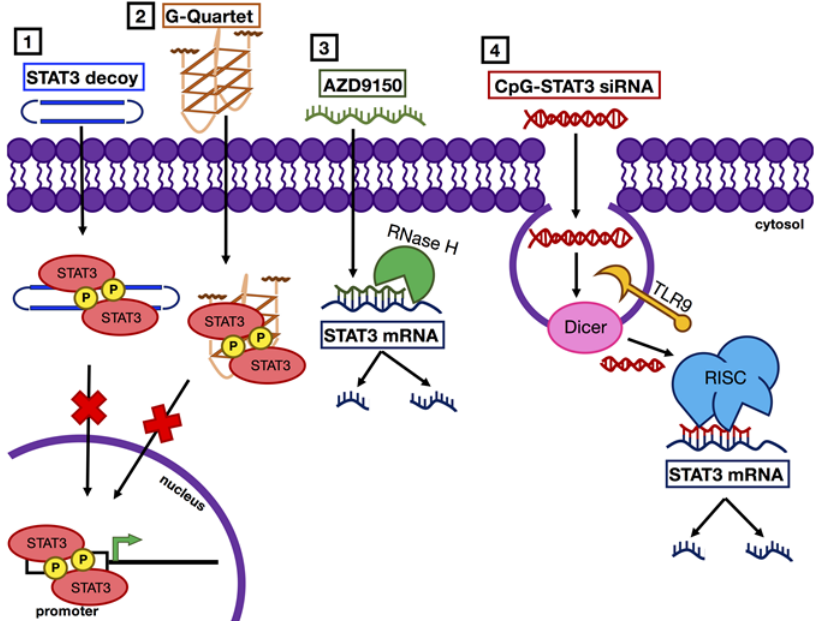
Figure 4. Mechanisms of STAT3 inhibition with nucleic acid-based agents. STAT3 inhibition with nucleic acid-based agents occurs via two main mechanisms: (1 and 2) STAT3 decoys or G-quartet deoxyoligonucleotides prevent STAT3 binding to promoter regions of target genes, and (3 and 4) antisense or siRNAs promote degradation of STAT3 mRNA.